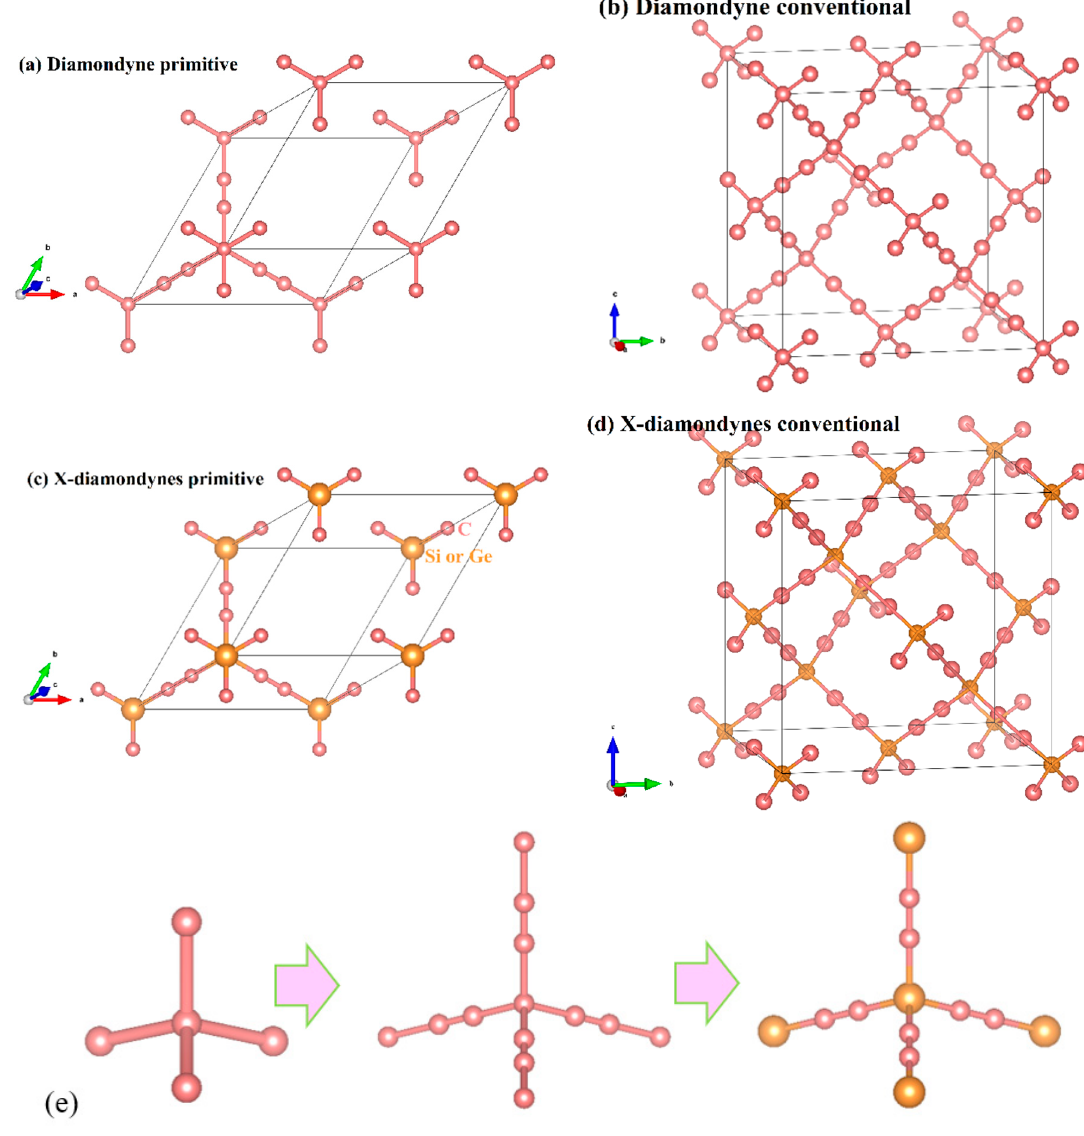
Figure 1. The crystal structures of ( a , b ) diamondyne; ( c , d ) Si-diamondyne; and ( e ) tetrahedral structures of diamond, diamondyne and Ge-diamondyne, from left to right.